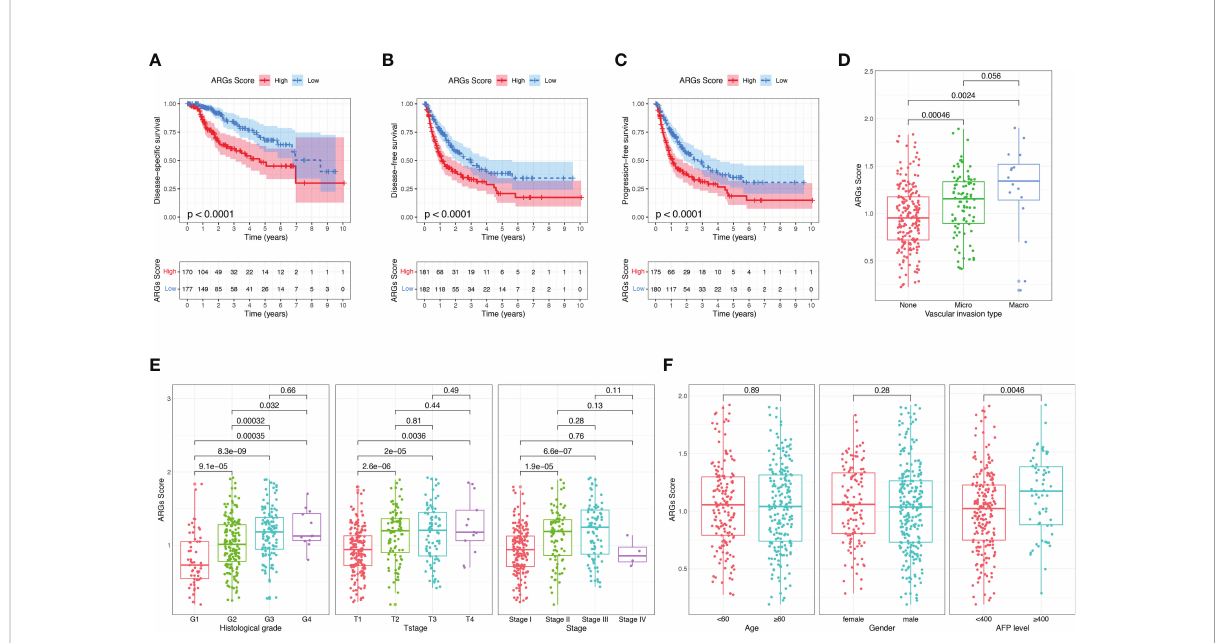
FIGURE 6 Correlation between the ARGs Score and clinical features in TCGA dataset. (A – C) The disease-free survival, disease-speci fi c survival and progression-free survival analyses between the high-score and low-score groups. (D) The relationship between the ARGs Score and vascular invasion type. (E, F) Correlation of the ARGs Score with clinical stage, T stage, histological grade, age, gender and AFP level.